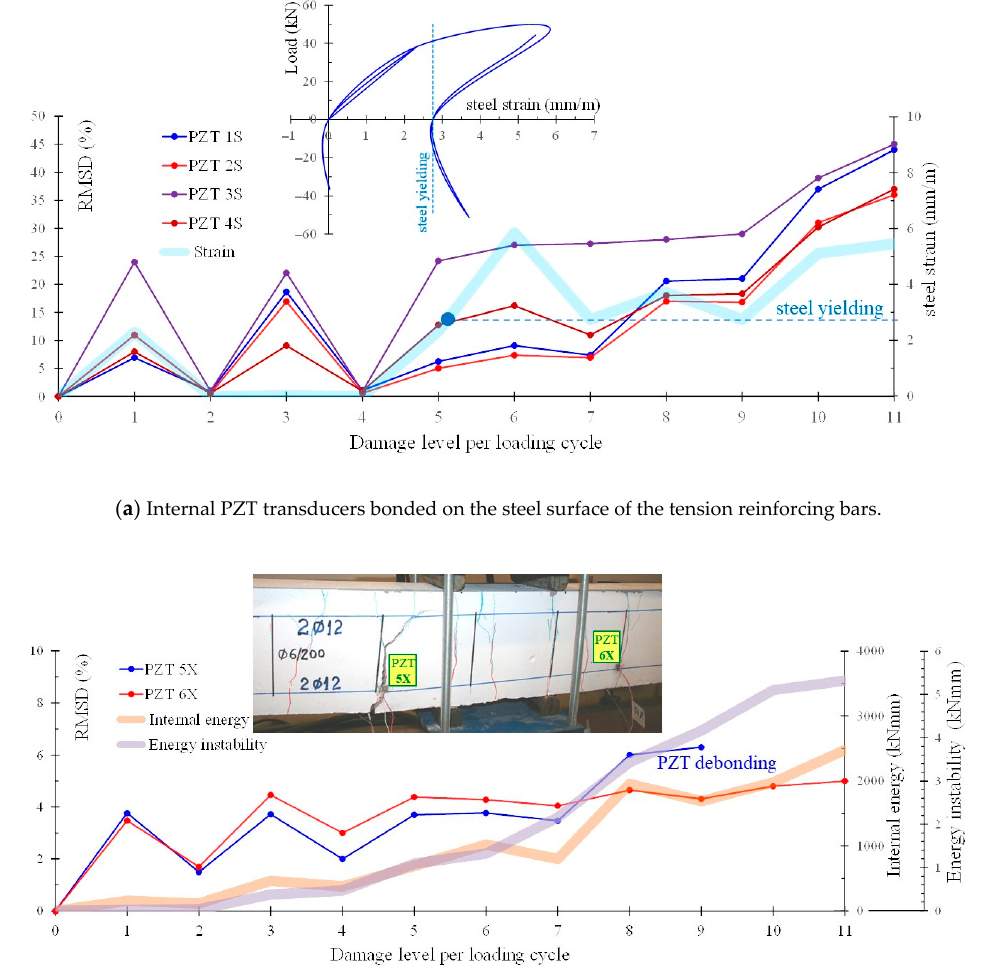
Figure 15. Values of RMSD index evaluated from the voltage frequency response signals of the PZT transducers for different level of loading/damage of the FLC beam.